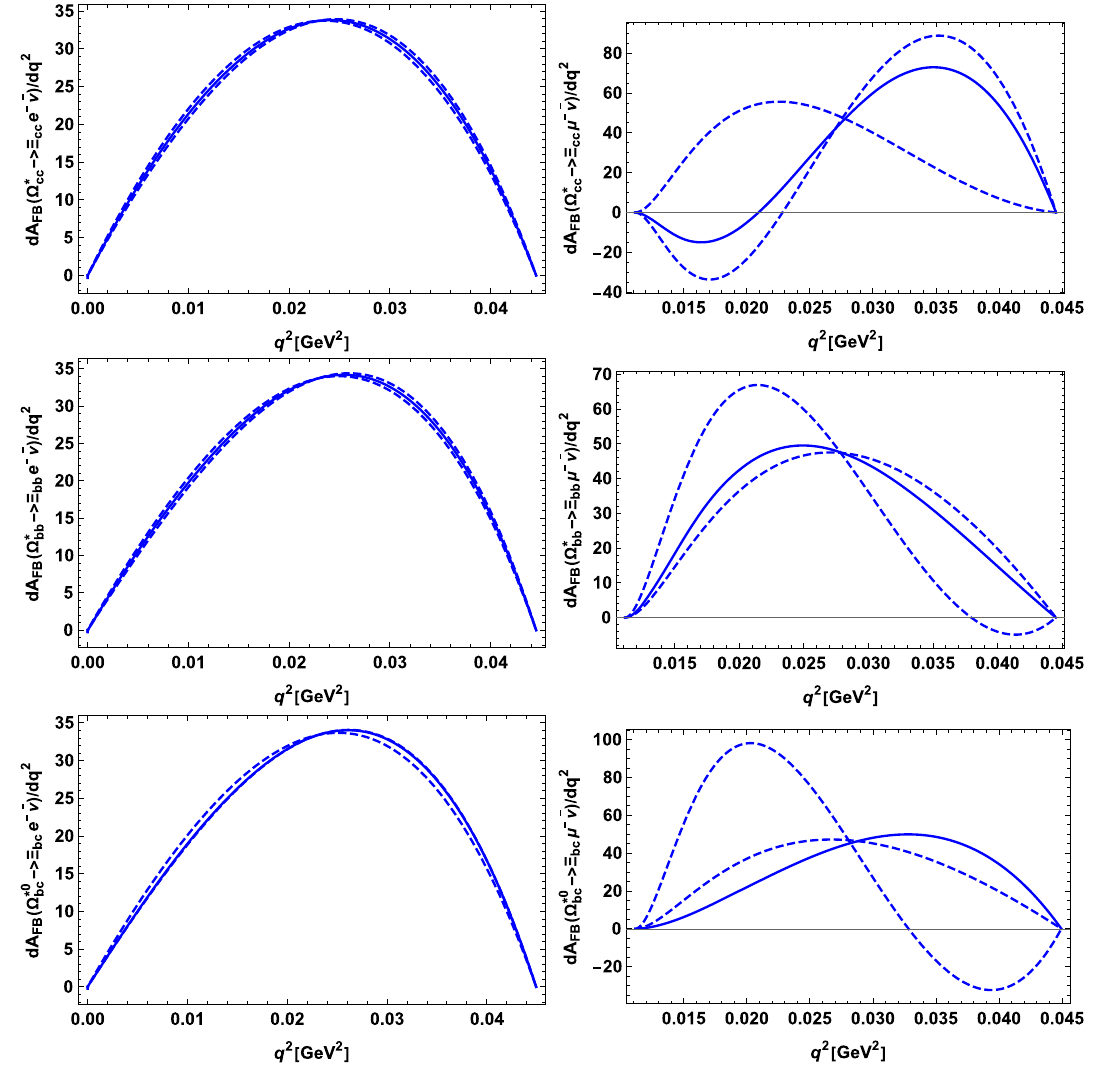
Fig. 8 The dA FB / dq 2 of spin-3/2 to spin-1/2 doubly heavy baryon decay processes. dA FB / dq 2 is depend on F ( q 2 )